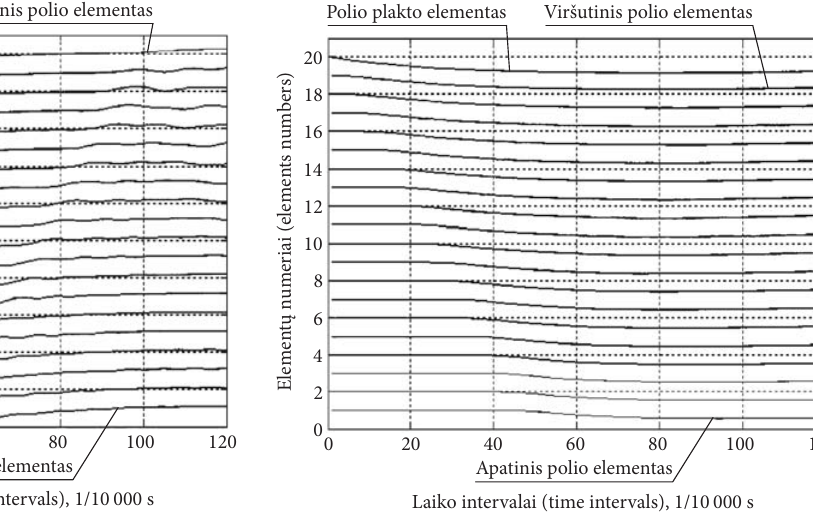
Fig. 3. Idealizated segments speed of pile scheme versus time